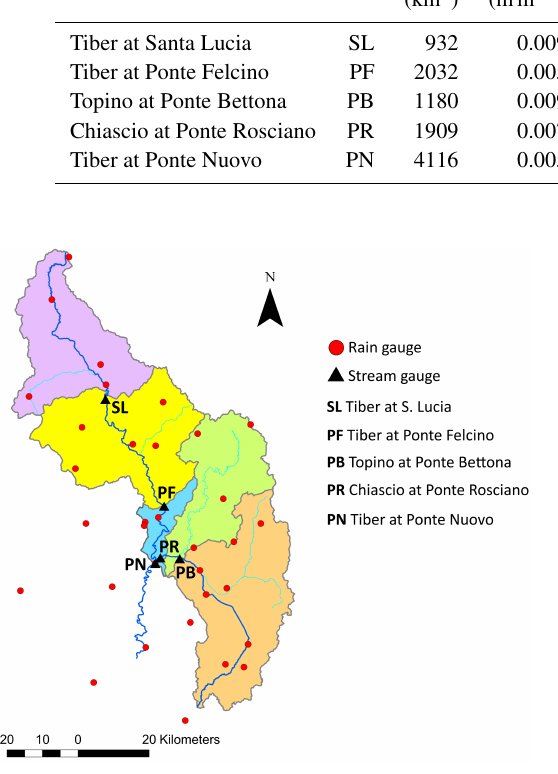
Figure 3. Map showing the subdivision of the watershed into five inter-basins, each one identified by a node where water discharge is computed (black triangles). The locations of the meteorological stations are also shown as colored